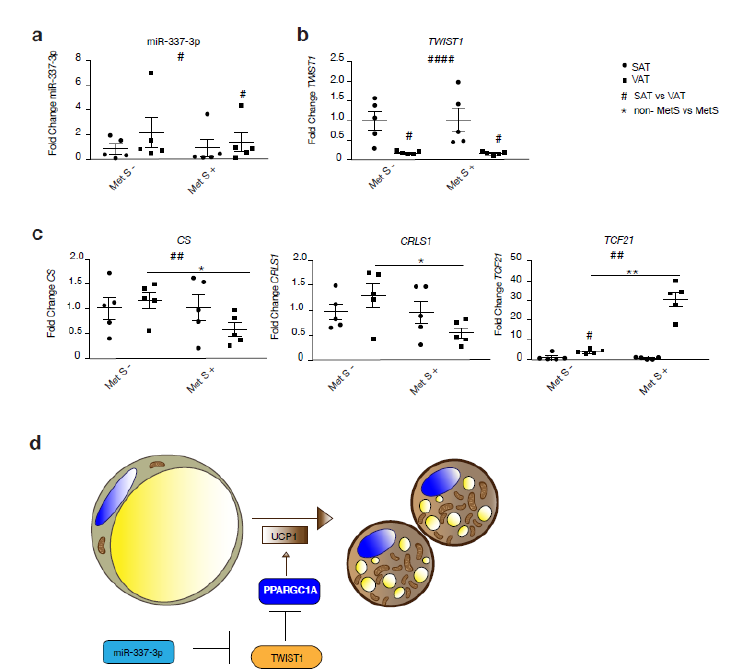
Figure 5. The miR-337-3p and Twist1 axis is disrupted in human subjects with MetS. ( a ) RT-PCR analysis of hsa-miR-337-3p in human VAT and SAT from non-MetS and MetS human subjects (n = 5 / group). ( b ) RT-PCR analysis of TWIST1 in human VAT and SAT from non-MetS and MetS human subjects (n = 5 per group). ( c ) RT-PCR analysis of TCF21 and mitochondrial genes CRLS1 and CS in VAT and SAT from non-MetS and MetS human subjects (n = 5 per group). ( d ) Illustration of the pathway proposed in the present study through which miR-337-3p induces browning of adipose tissue. TWIST1, when activated, inhibits PPARGC1A, which prevents the transcription of genes involved in brown fat metabolism. In summary, miR-337-3p induces translational inhibition of TWIST1 and prevents transcriptional inhibition of genes involved in the browning of adipose tissue. Data are presented as means ± SEM, and individual data points are given by the dot plot. L7 mRNA was used as an internal normalizer to the number of mRNA transcript copies. 5S RNA was used as an internal normalizer to miRNA transcript copies. # p < 0.05; ## p < 0.01; #### p < 0.0001; Paired sample t -test (SAT vs. VAT) * p < 0.05; ** p < 0.01 Independent sample t -test (non-MetS vs. MetS), n, number of biological